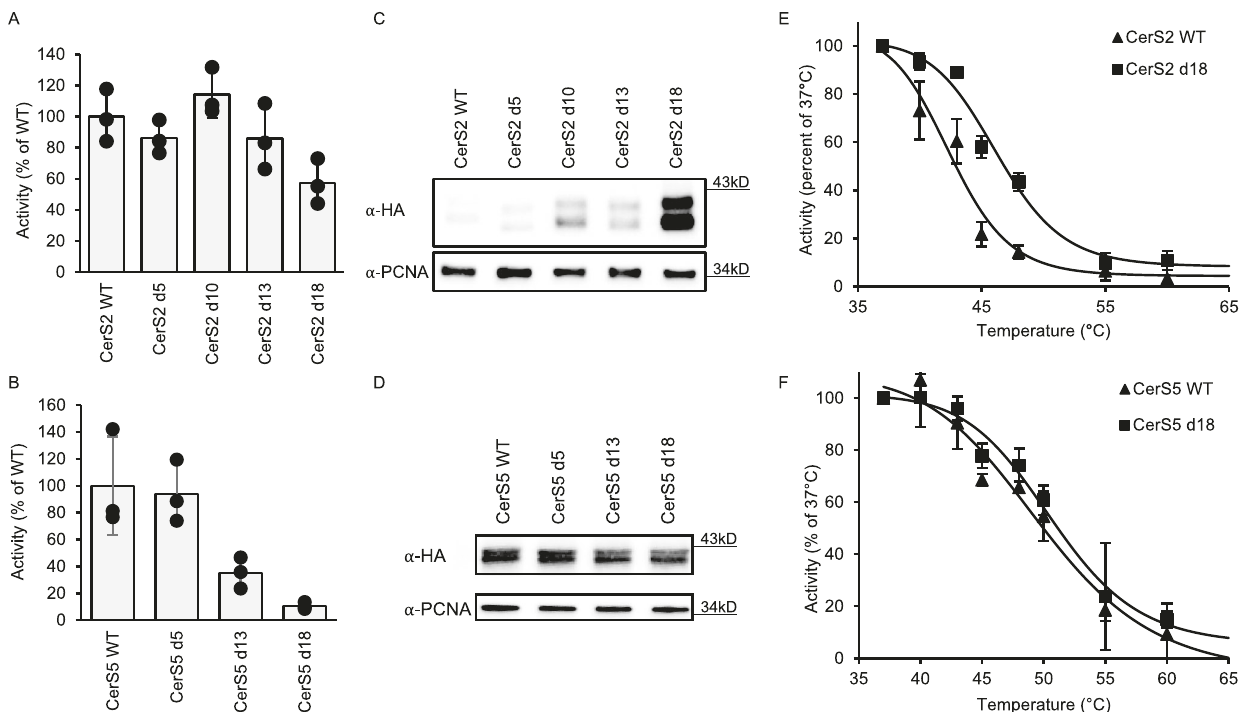
Fig. 2 | Gain of function mutations in CerS2 introduced by mPROSS. Homo- genates were prepared from A HEK CerS2 − / − cells overexpressing the indicated CerS2 designsand B WTHEKcellsoverexpressingtheindicatedCerS5designs.Resultsare shown as a percent of the activity incellsoverexpressing the WTenzyme;means ± S.D. n =3. Expression levels of CerS2 C or CerS5 D designs in WT HEK cells were ascertained by western blotting using an anti-HA antibody and anti-PCNA as